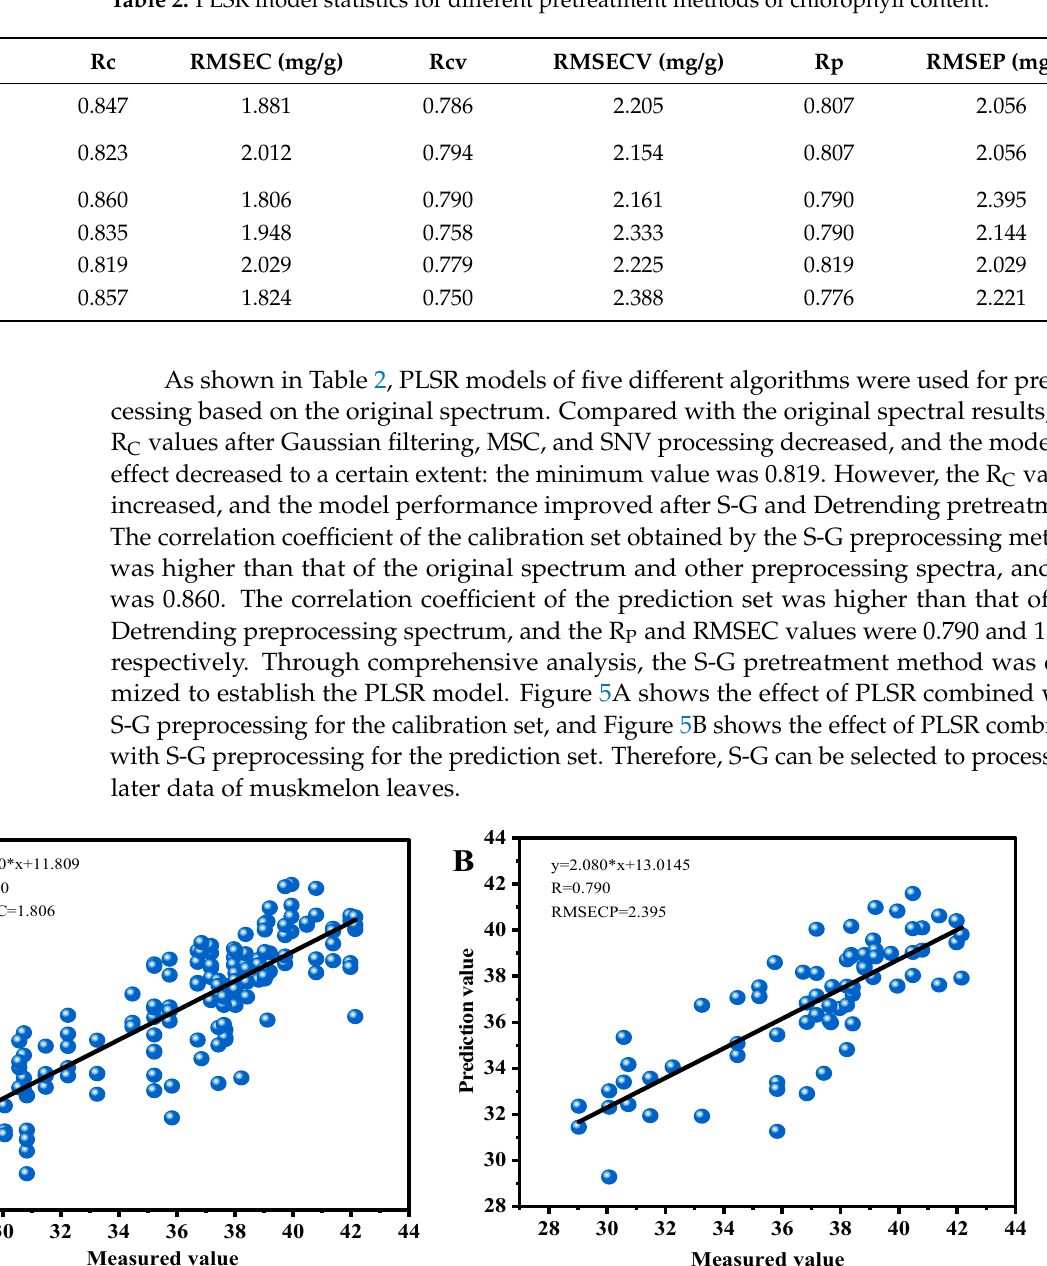
Table 2. PLSR model statistics for different pretreatment methods of chlorophyll content.